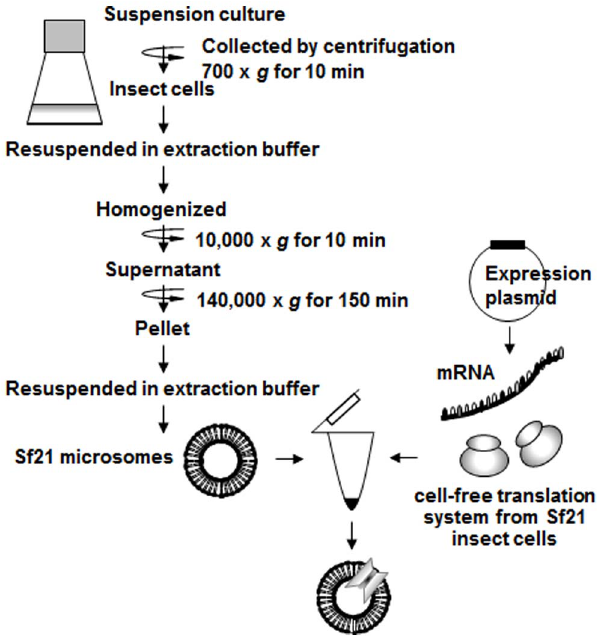
Fig. 1. Flow chart for the preparation of microsomes from Sf21 cultured insect cells. Fewer centrifugation and wash steps were required compared to the conventional protocol for the preparation of rough microsomes from dog pancreas and the composition of the buffer was simplified. Single-tube reactions consisting of Sf21microsomes, cell-free translationally active lysates from cultured insect cells and mRNA were performed to synthesize membrane proteins in vitro